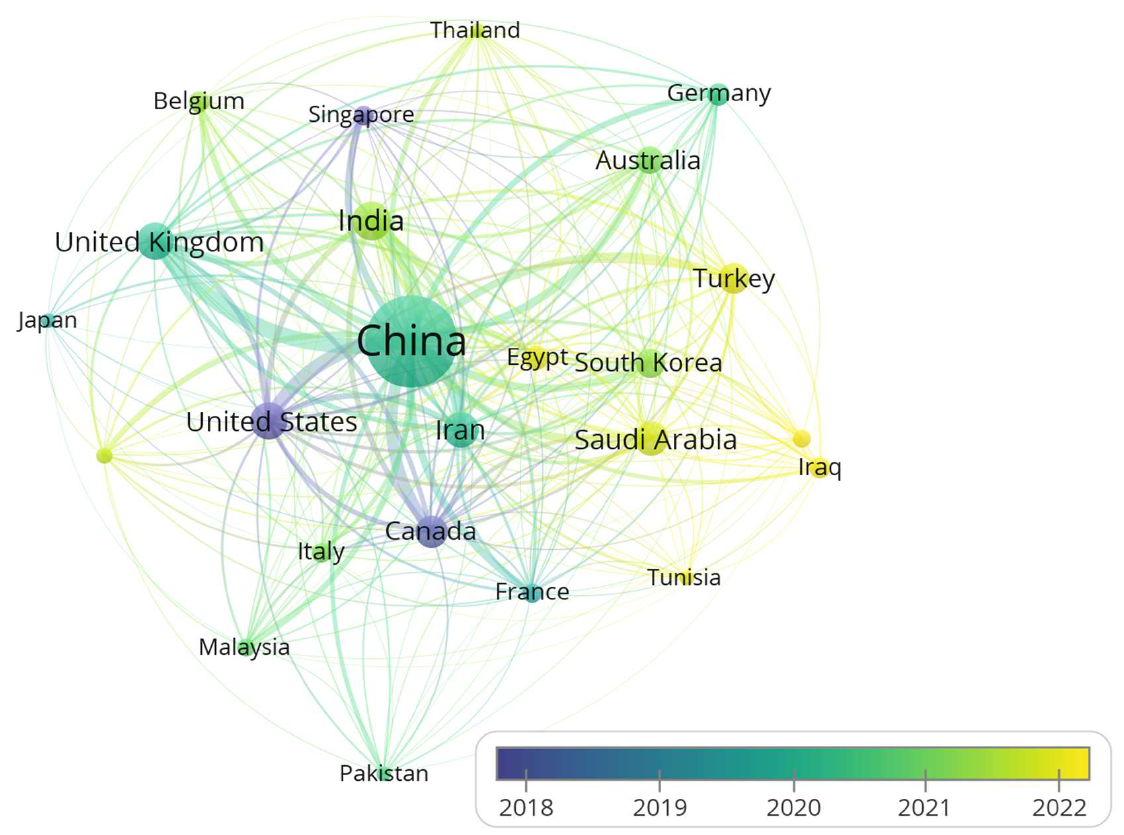
Figure 3. Relationship between countries and years.